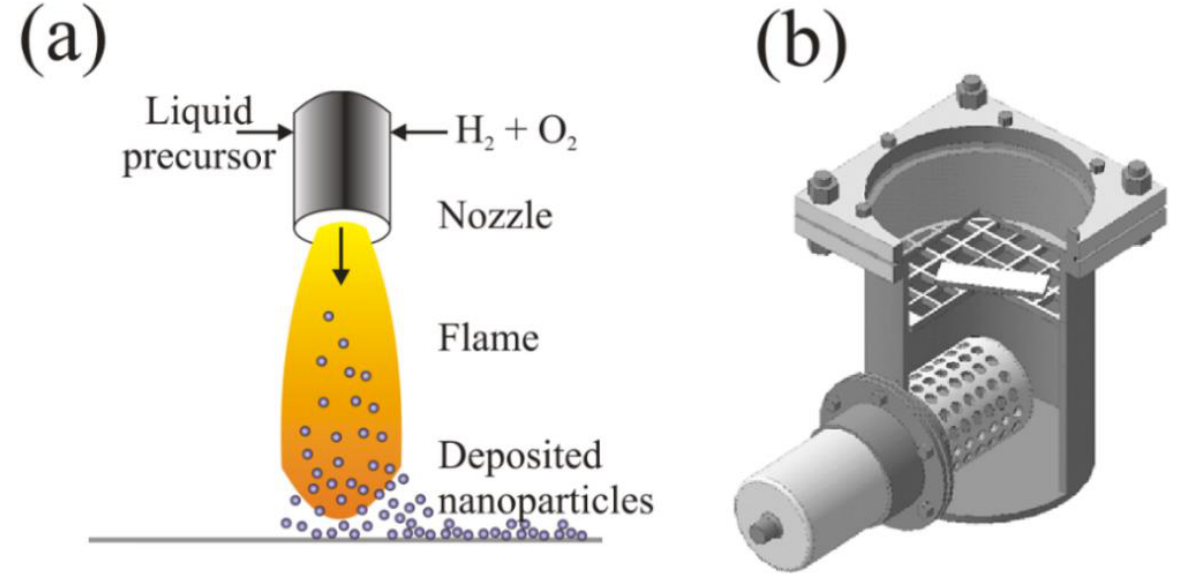
Figure 7. Schematic picture of ( a ) LFS nanoparticle deposition and ( b ) the used gas-phase detector for photocatalytic activity characterization.